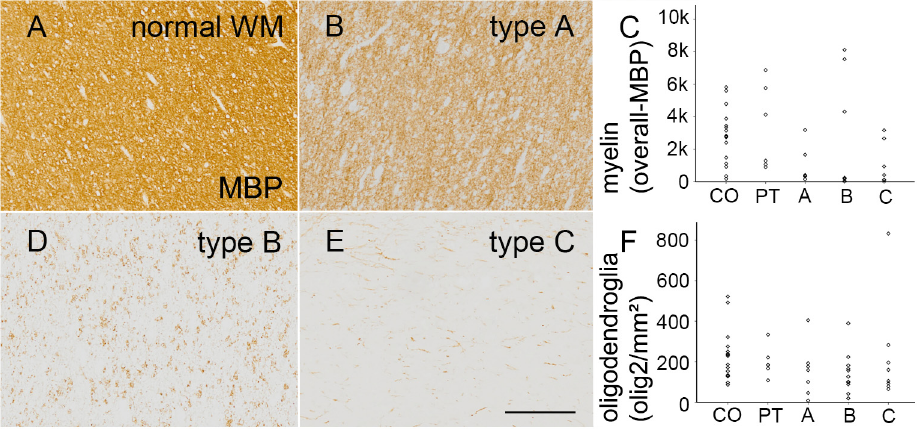
Fig 4. White matter pathology in cortical tubers. A. Normal appearing white matter content of the temporal lobe in a 17-years old autopsy case (MBP staining). B. + D. + E. Representative sections of WM within the 3 different tuber types (MBP). Scale bar in e = 100 μ m and applies also to a , b , and d . C. Significant reduction of myelin content. F. Equal distribution of oligodendroglial cells among all tuber types. CO = control; PT = perituberal cortex